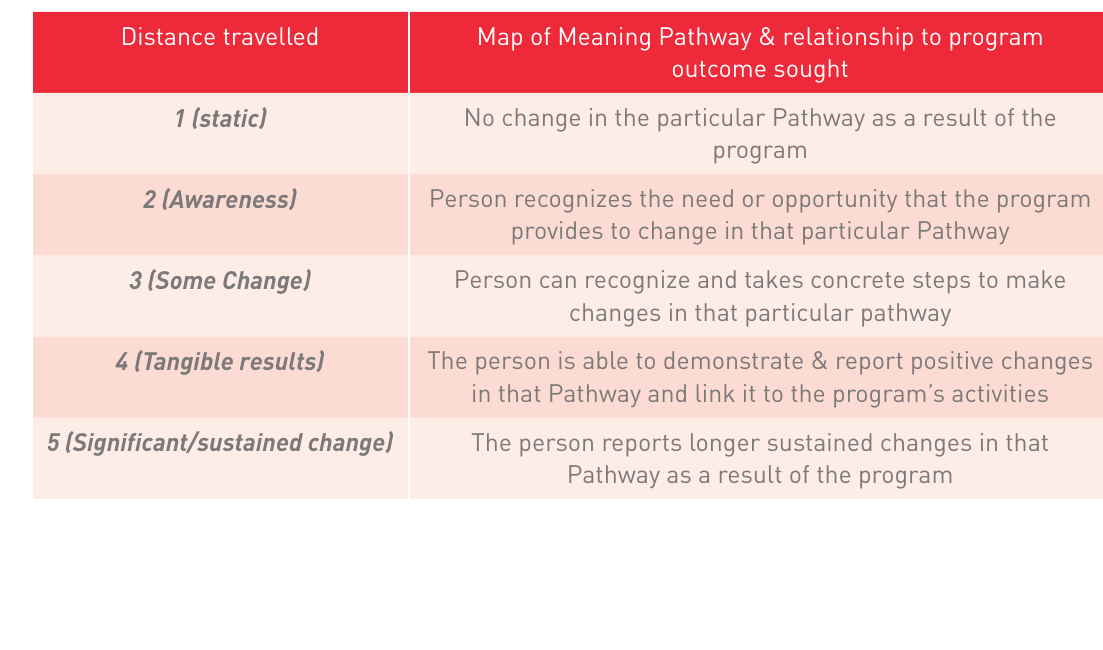
Using Distance travelled with Meaningful Evaluation Distance travelled Map of Meaning Pathway & relationship to program outcome